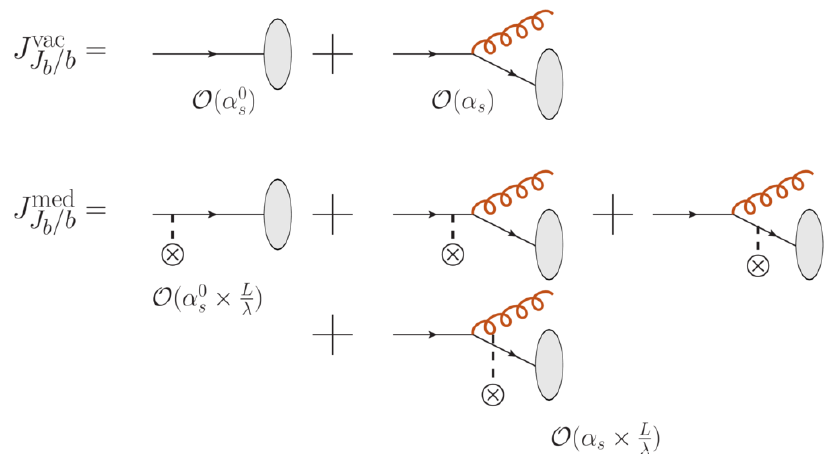
Figure 1 . Illustration of real diagrams contributing to the b QCD. The first line shows the diagrams for the LO and NLO contributions to the vacuum jet function, while the second and third lines are the corresponding medium corrections to vacuum diagrams up to the first order in opacity. The dashed lines represent the Glauber gluon exchange between the jet and the QCD